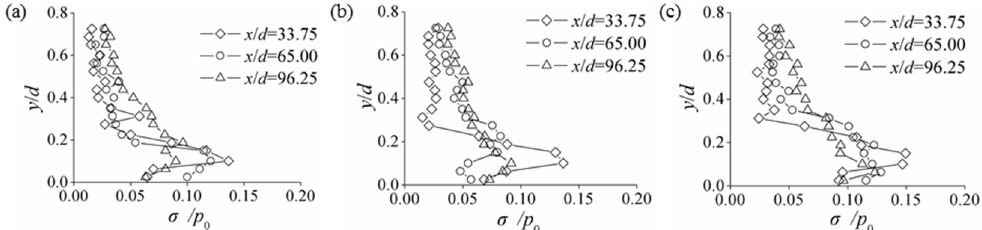
Figure 9. Dimensionless distributions of flow fluctuation at x direction in cross-sections: ( a ) Q = 0.18 m 3 /s; ( b ) Q = 0.19 m 3 /s; ( c ) Q = 0.21 m 3 /s.